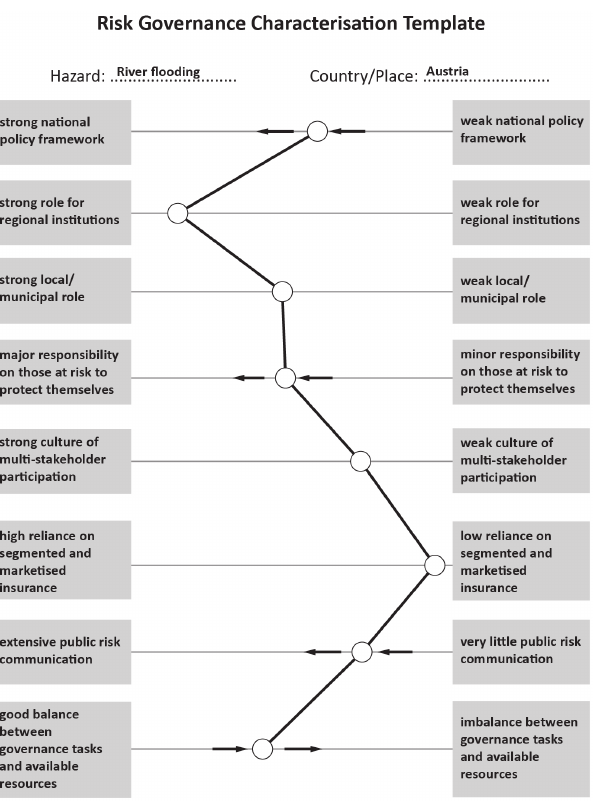
Fig. 6. Example of risk governance profile – River flooding in Aus- tria.